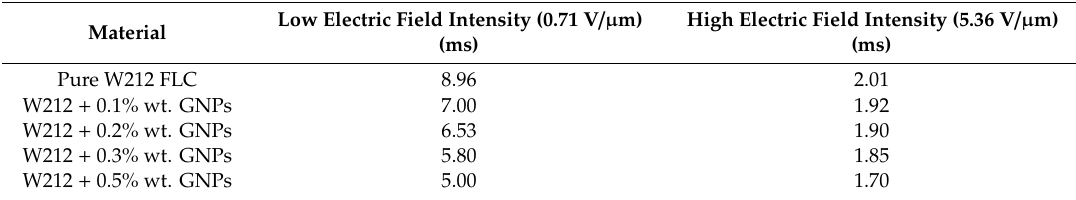
Table 3. The response times for PCFs infiltrated with W212 FLC doped with different concentrations of GNPs. The values are given for the lowest and highest values of electric field intensity.